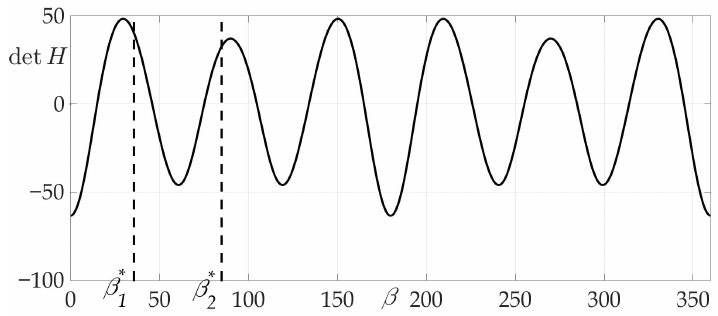
Figure 9. Dependence of Hessian det H from β .